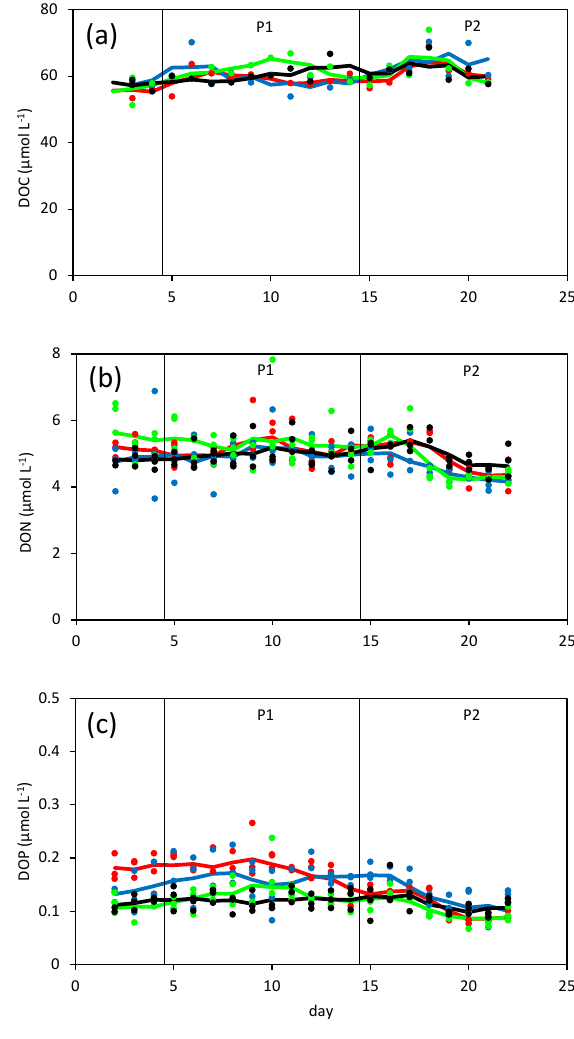
Figure 3. Temporal evolution of (a) particulate organic carbon (POC), (b) particulate organic nitrogen (PON), (c) particulate or- ganic phosphorus (POP) concentrations (µmolL − 1 ) in the meso- cosms and surrounding waters. The color code is identical to that in Fig. 1. The three dots of each color represent the measured val- ues at the three sampled depths. The solid lines are the 3-day run- ning mean value. P1 and P2 denote the two phases of the experi- ment when the diazotrophic community was dominated by diatom– diazotroph associations and unicellular N 2 -fixing cyanobacteria (group C), respectively.